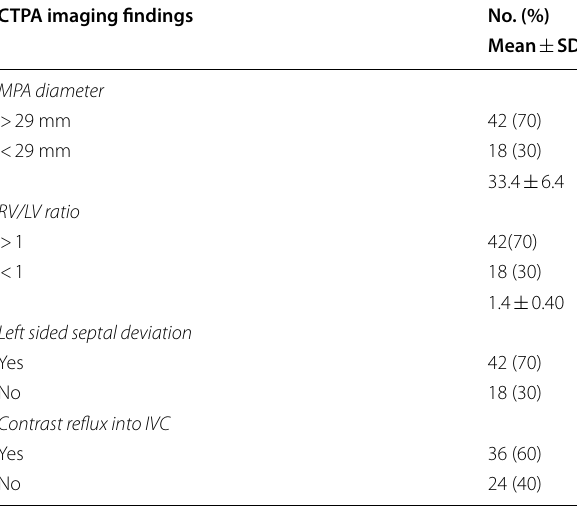
Table 1 Summary of CTPA findings